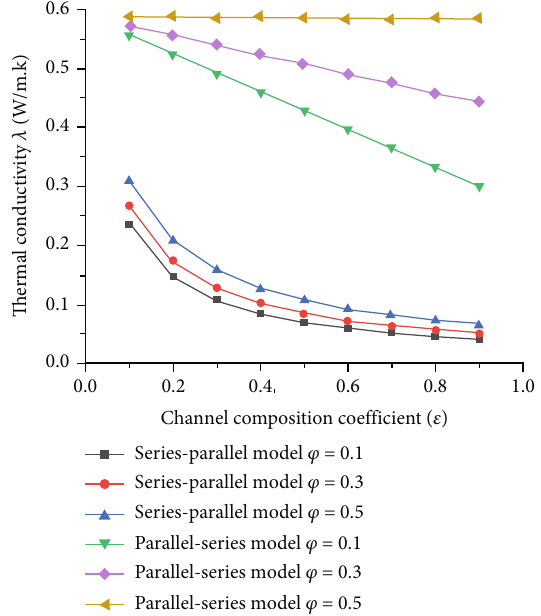
Figure 22: Relationship between thermal conductivity λ and channel composition coe ffi cient ε of comprehensive REV model with di ff erent moisture percentage ϕ .